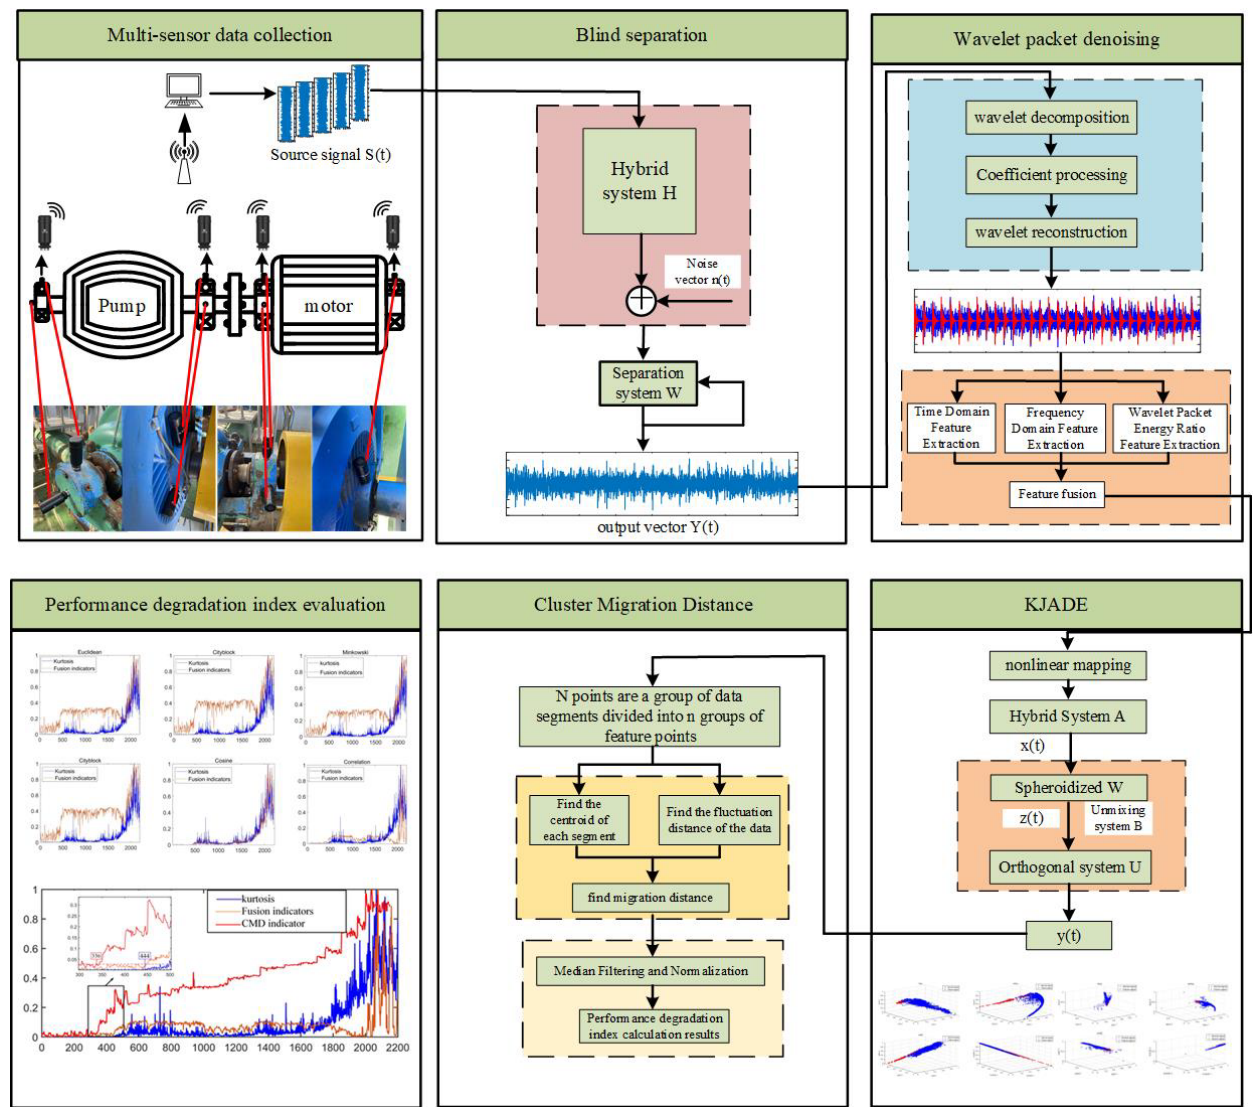
Figure 1. Overall flow chart.